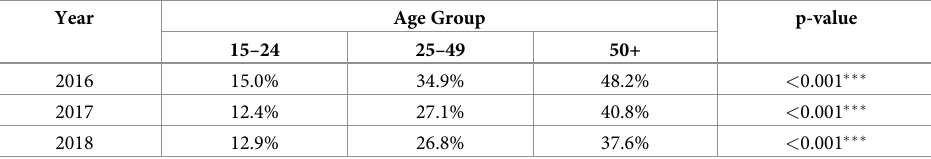
Table 1. Percent of sample with CD4 count < 200 cells/mL at time of HIV diagnosis by